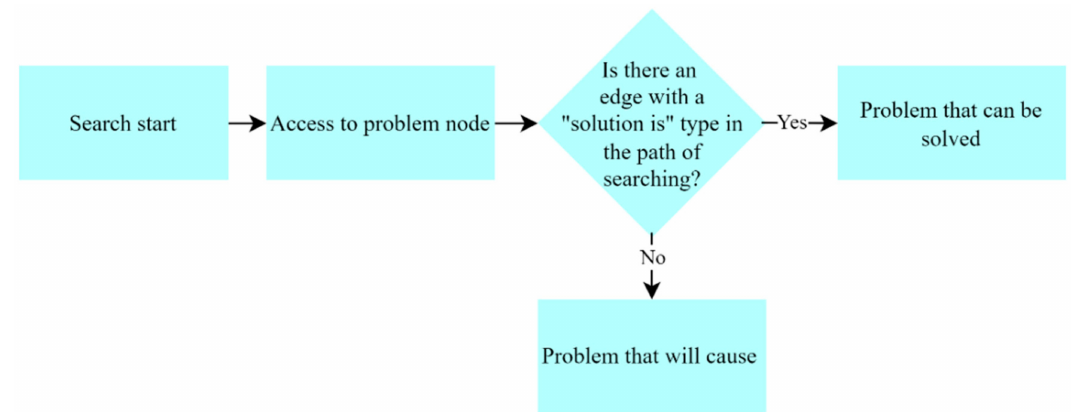
Figure 8. Phenomenon node search logic.